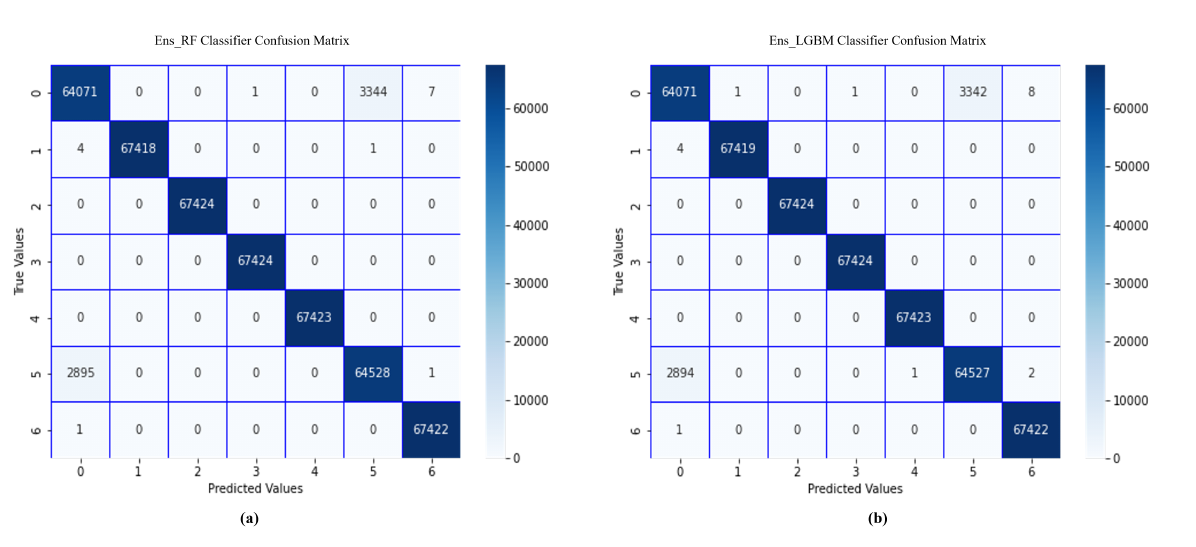
Figure 5. Confusion matrix for ( a ) Ens_RF and ( b ) ENs_LGBM on 2018 dataset.